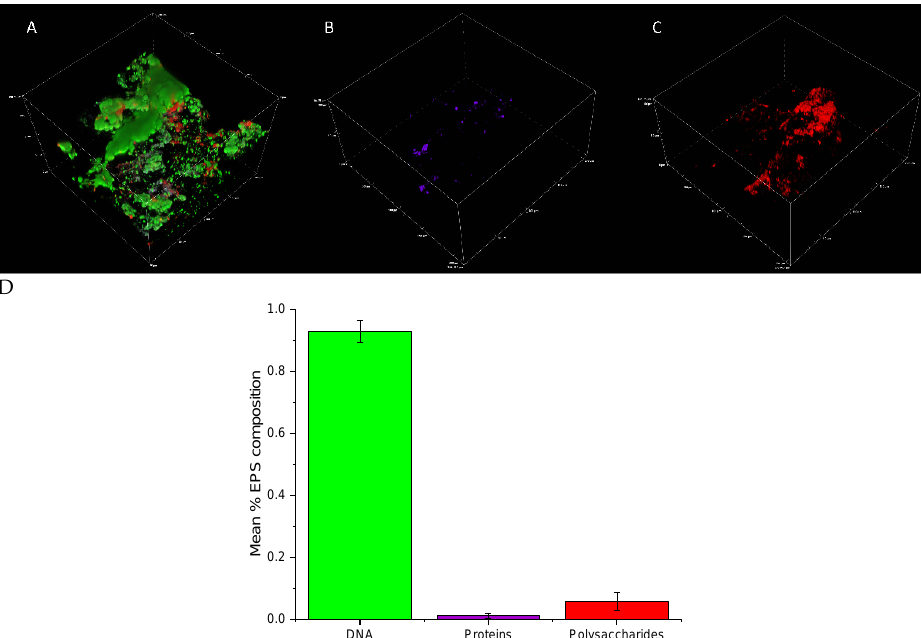
Figure 2. ( A – C ) Confocal micrographs of early biofilms (2 weeks) depicting the EPS composition, where ( A ) all channels combined, ( B ) protein-targeting channel, and ( C ) polysaccharide-targeting channel. ( D ) IMARIS (Bitplane) analysis depicting the average percent contributions of eDNA, proteins, and polysaccharides to the matrix of biofilms from experimental replicates. Error bars represent the standard deviation of triplicate micrographs.